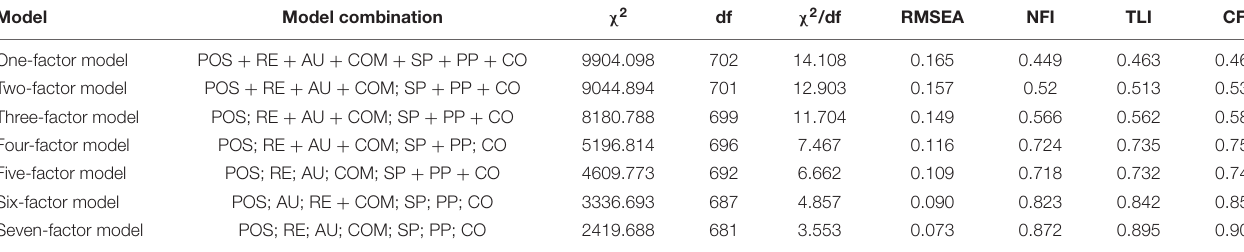
TABLE 1 | Results of confirmatory factor analysis.